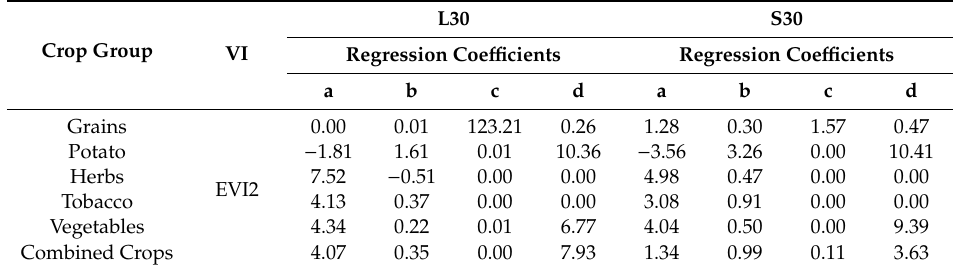
Table 7. Regression coe ffi cients obtained by regressing LAI against EVI2 using the equation of the form and S30.